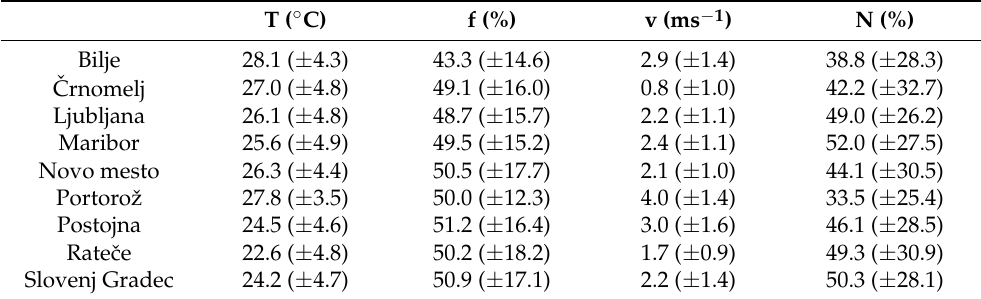
Table 2. Universal Thermal Climate Index (UTCI) threshold values regarding heat thermal stress